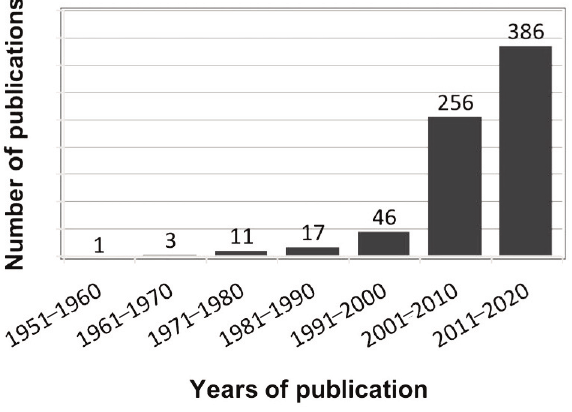
Fig. 2. Number of published papers found in the Google Scholar database under the keyword ‘aza-peptide’.